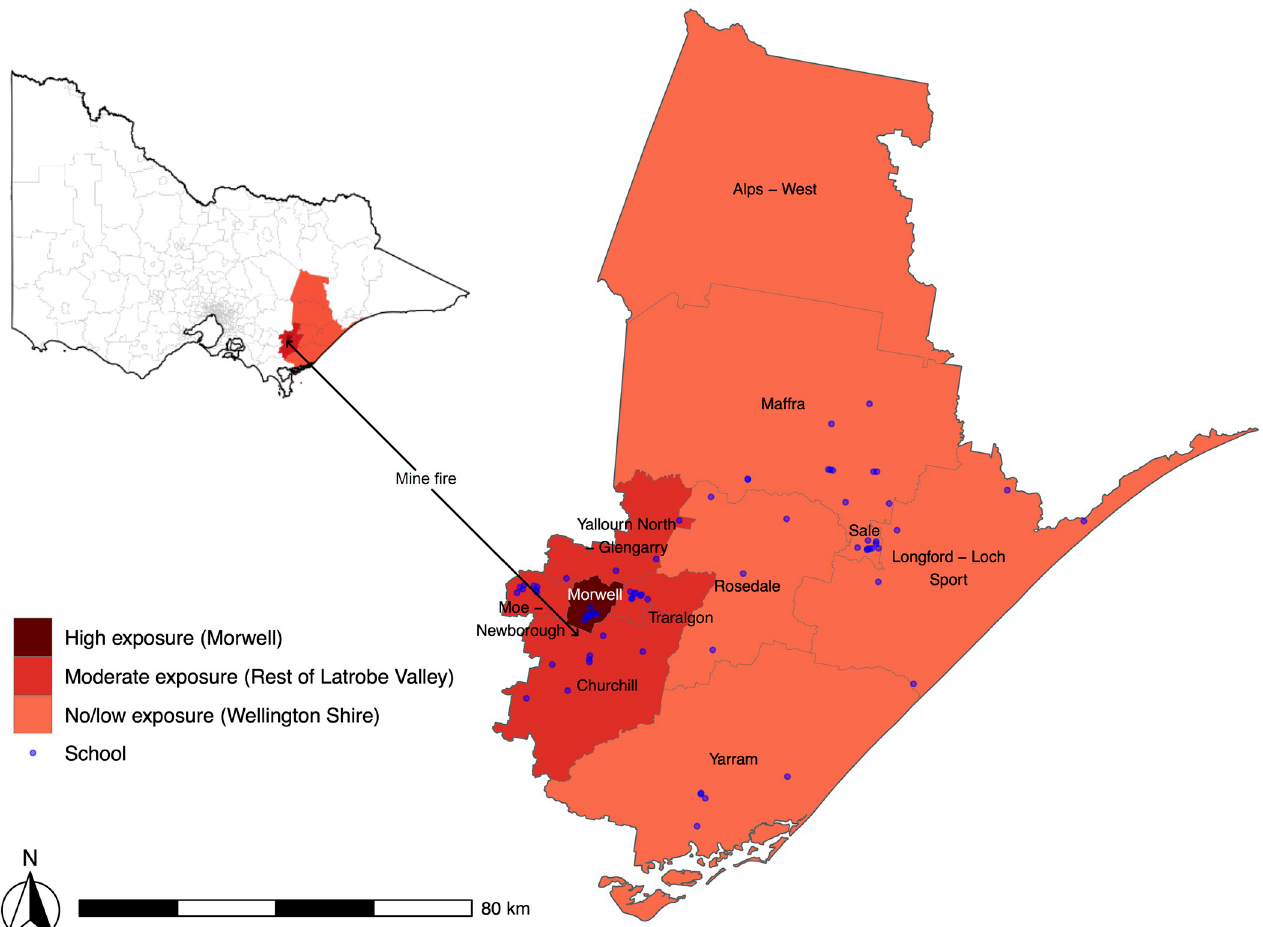
Fig 1. Map of selected mine fire exposed SA2s in Victoria. Superimposed dots are the location of schools in the impacted areas.